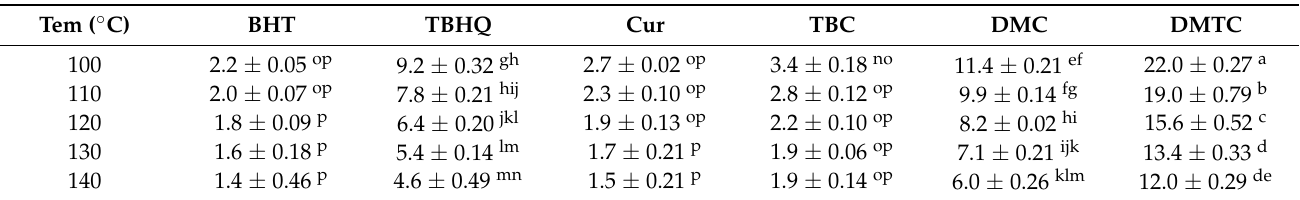
Table 3. Protection factors (Pfs) of Cur and its derivatives (0.02%), and comparison of antioxidants at various temperatures (100, 110, 120, 130, and 140 °C).